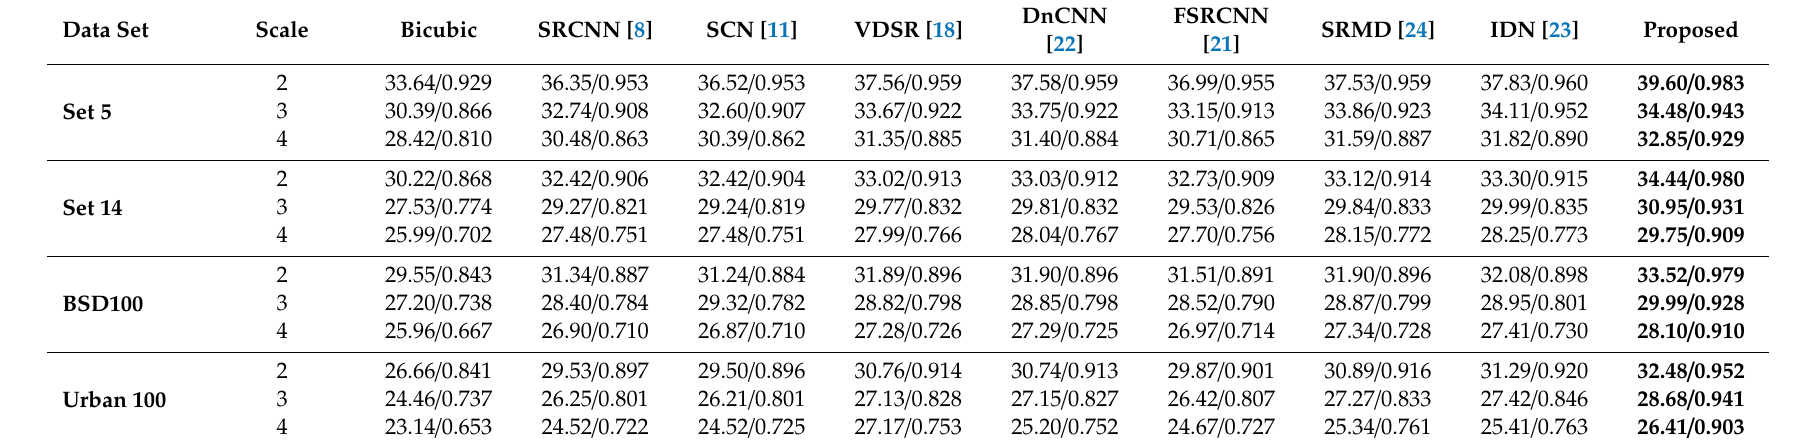
Table 2. Comparative results based on PSNR (left) and the structural similarity index measure (SSIM)